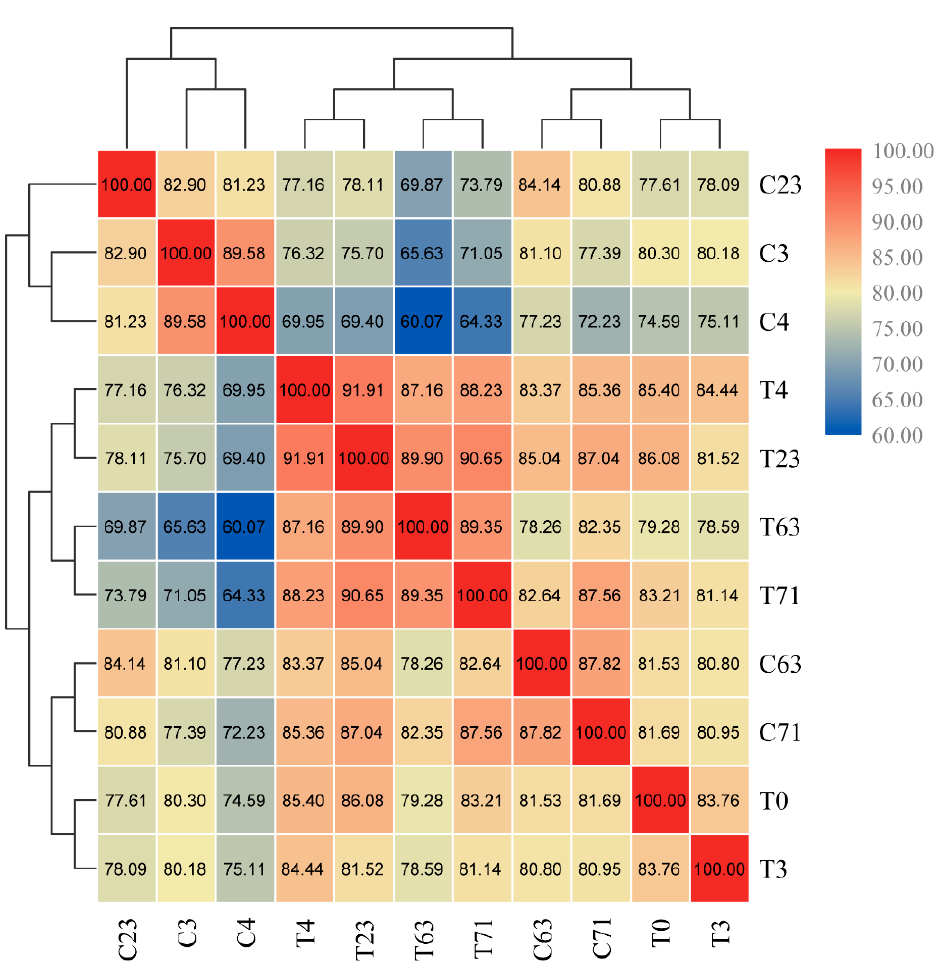
Figure 3. Spearman’s rank correlation coefficient of all metabolite profiles from samples collected at all sampling time. C indicates samples from trees in the control group. T indicates samples from trees in the girdled group. The numbers 0, 3, 4, 23, 63, and 71 indicate the sampling time.